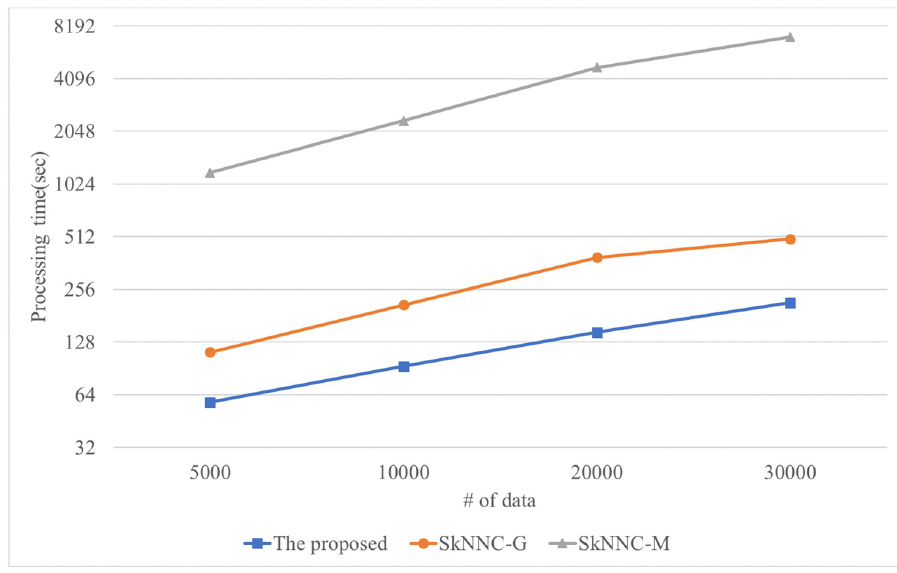
Fig 10. Processing time with varying the number of